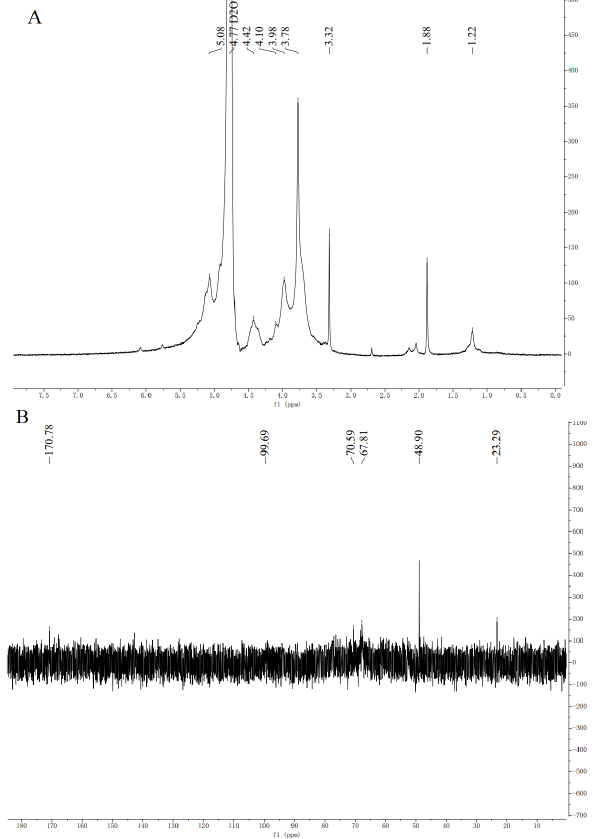
Figure 4. ( A ) The 1 H NMR spectra of HCPS, ( B ) 13 C NMR spectra of HCPS.